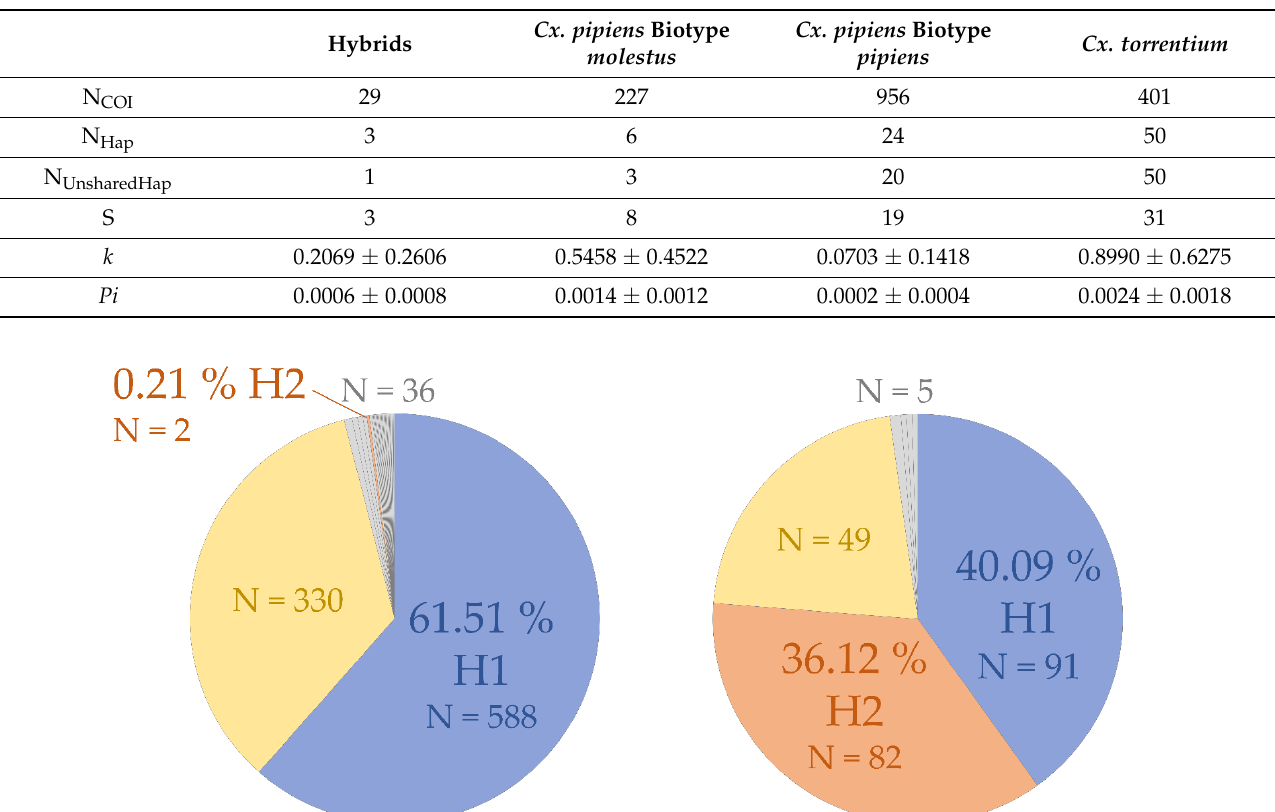
Table 2. COI sequence diversity of Culex pipiens s.s. biotypes and Cx. torrentium , calculated using Arlequin v3.5. Hybrids = Cx. pipiens biotype molestus x Cx. pipiens biotype pipiens , N COI = number